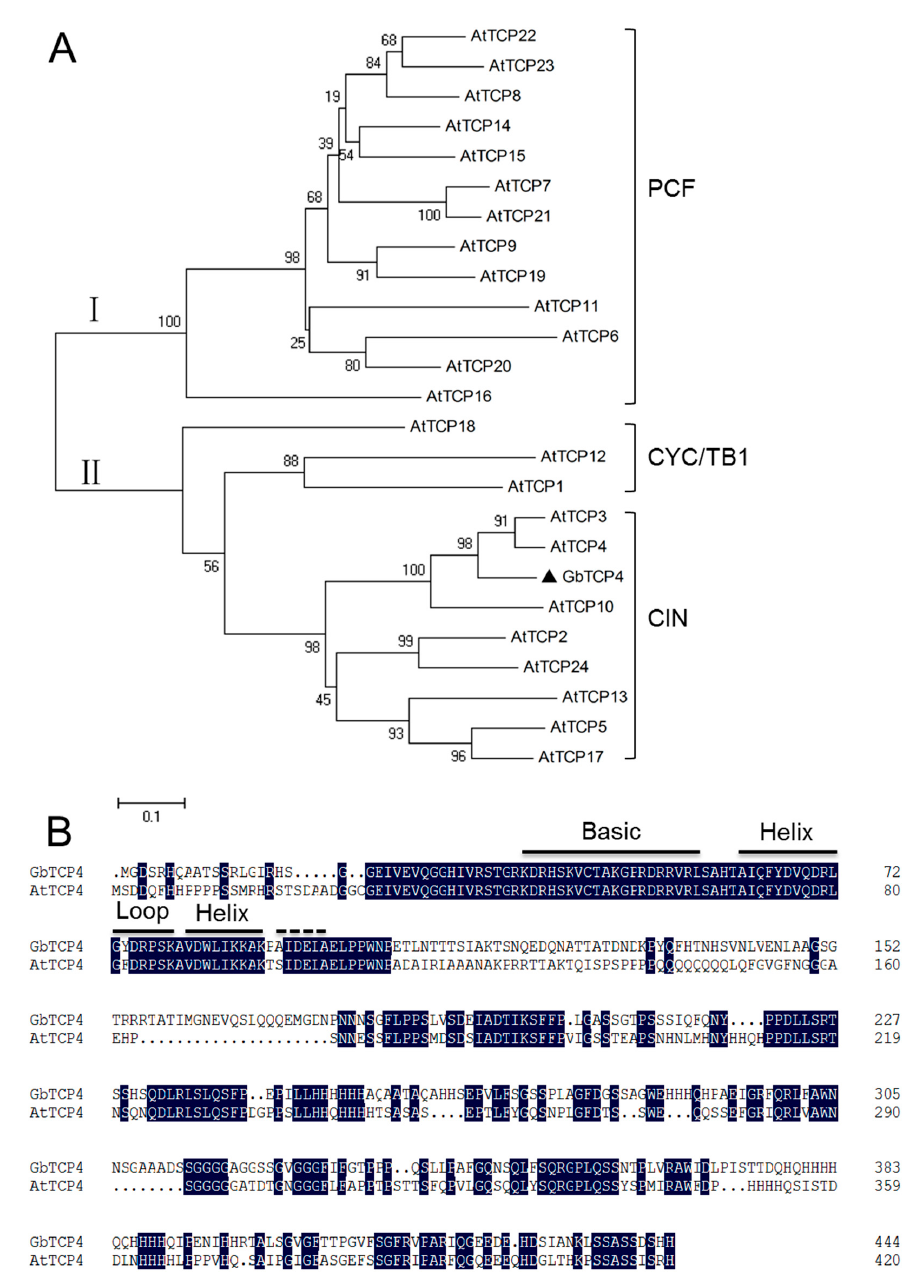
Figure 1. Phylogenetic tree analysis and sequence alignment of GbTCP4. ( A ) The phylogenetic tree of GbTCP4 and Arabidopsis TCP family proteins. The accession numbers of the proteins are as follows: AtTCP1, AT1G67260.1; AtTCP2, AT4G18390.1; AtTCP3, AT1G53230.1; AtTCP4, AT3G15030.1;